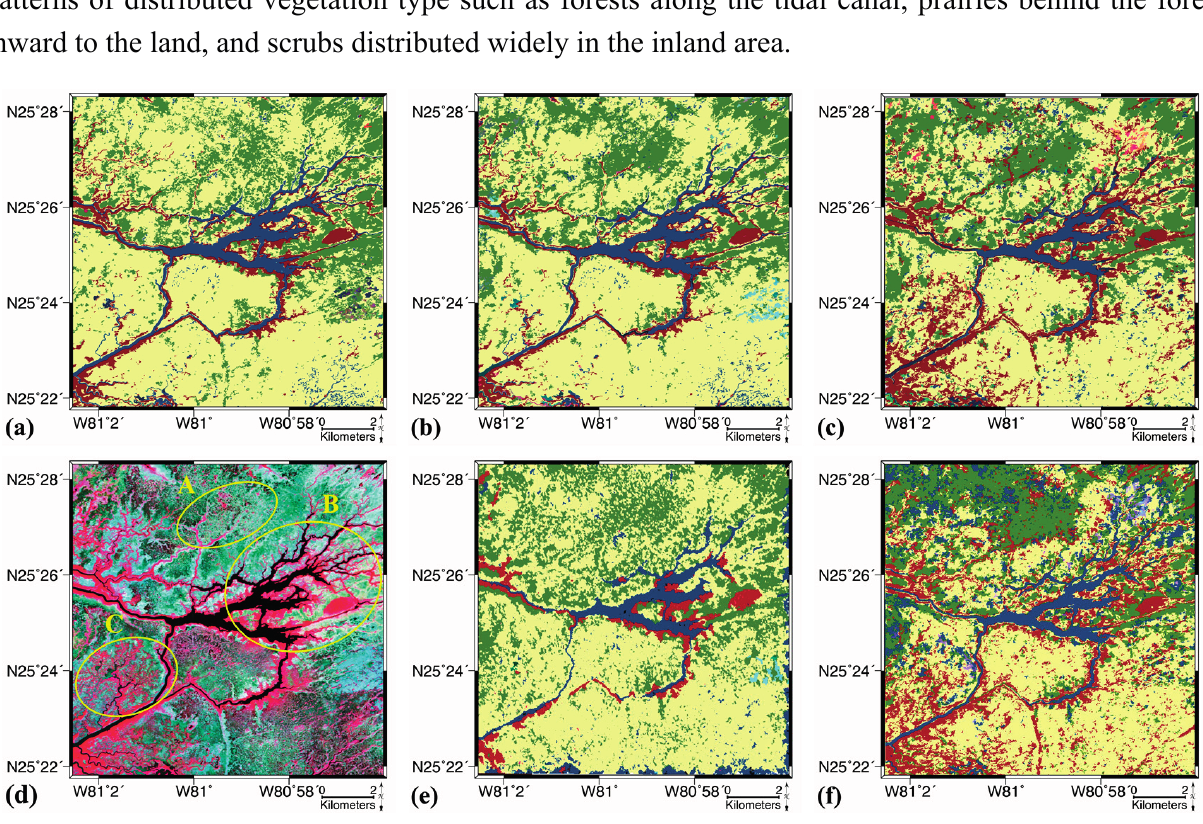
Figure 8. Classification results. ( a ) Scenario 1 (brown = forest, yellow = scrubs, green = prairie, blue = water); ( b ) Scenario 2; ( c ) Scenario 3; ( d ) RapidEye image with false-color combination (red = NIR, green = red visible, and blue = green visible); ( e ) Scenario 4; and ( f ) Scenario